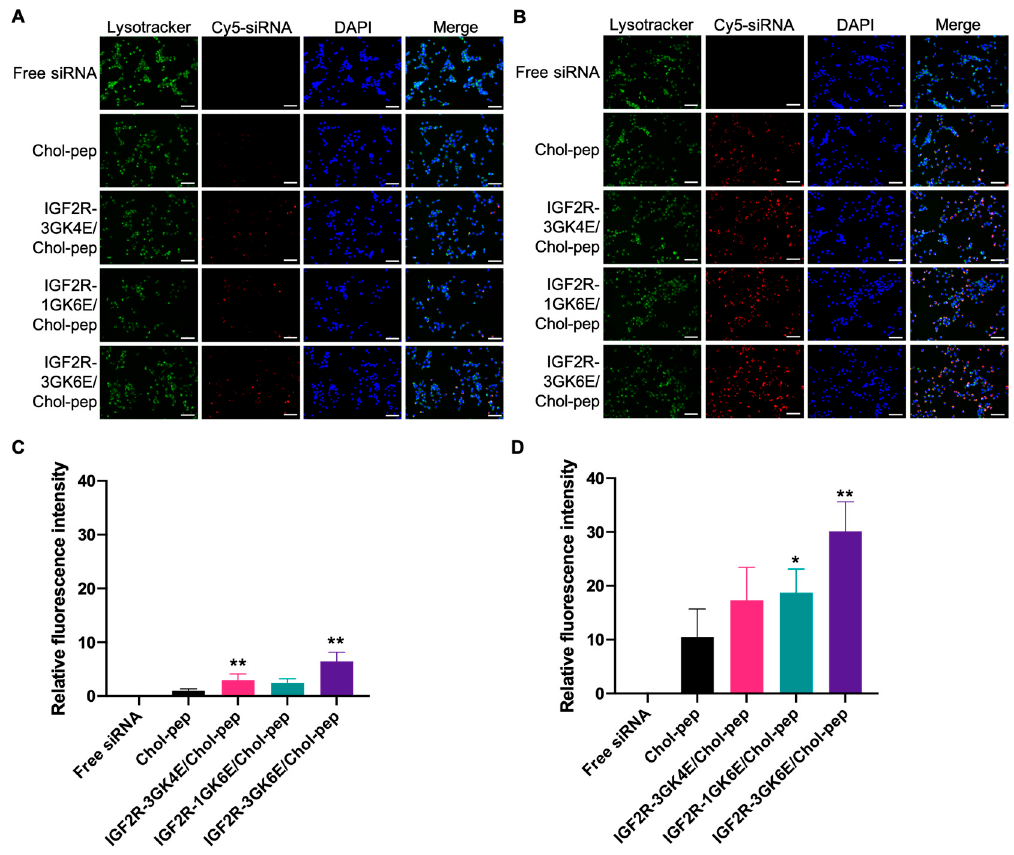
Figure 5. Cellular uptake study of a IGF2R peptide-modified nanocomplex in HSC-T6 cells using fluorescent microscopy. HSC-T6 cells were examined after incubation with free Cy5-labeled siRNA, Cy5-labeled siRNA nanocomplex, and IGF2R peptide-modified Cy5-labeled siRNA nanocomplex for 2 h ( A , C ) and 4 h ( B , D ). ( A , B ) Representative fluorescence images (scale bar = 100 µm). ( C , D ) Quantitative fluorescence analysis by ImageJ. Results are presented as the mean ± SD ( n = 6 images; * p < 0.05; ** p < 0.01).